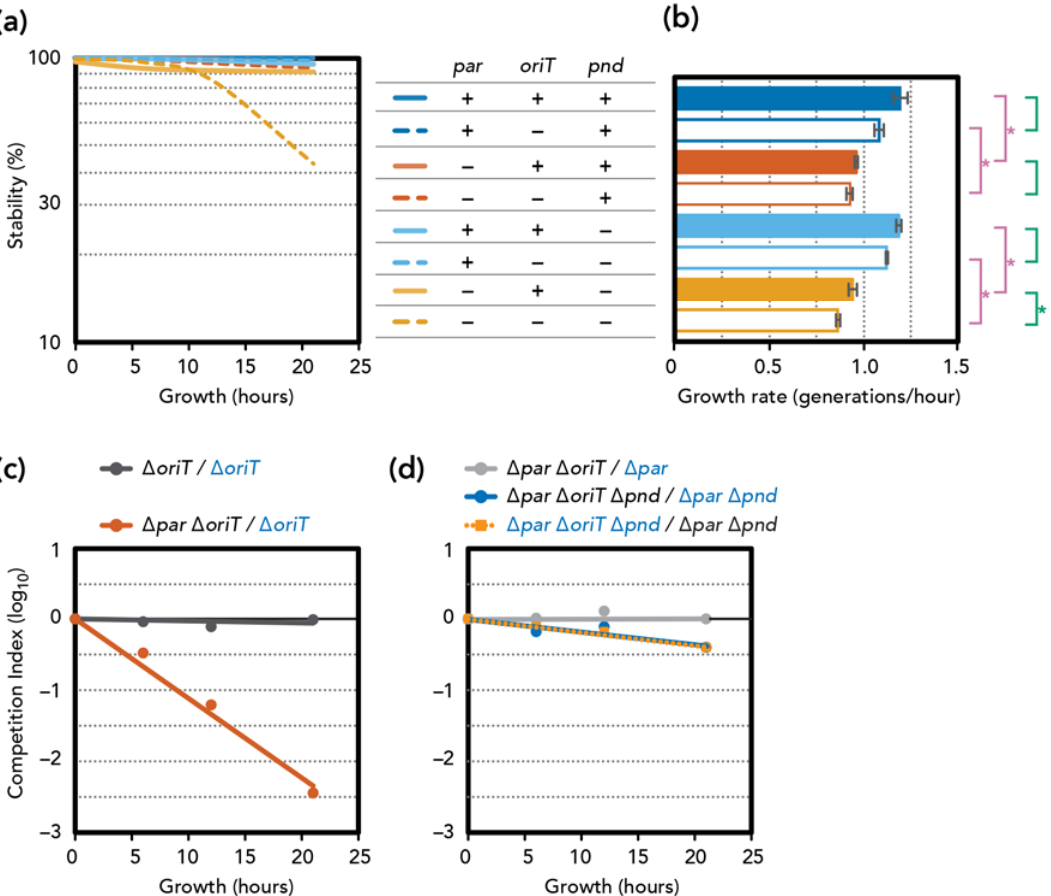
Figure 2. Phenotypes of pESBL mutants. ( a ) Stability of various pESBL mutants: presence and absence of genes are indicated by + and − , respectively. Averages of three independent experiments are shown. ( b ) Growth rate of pESBL mutants measured by plate reader. Average and standard deviations of three independent measurements are shown. For comparison between parABS +/ − (in magenta) and oriT +/ − (in green) counterparts, * denotes p < 0.01 in a two-tailed Student’s t -test. ( c , d ) Competition index (CI) between two co-cultured mutants. lacZ + derivatives are indicated in blue. The ratio of colony forming units was normalized to that of time 0, and an average of three independent experiments is shown.